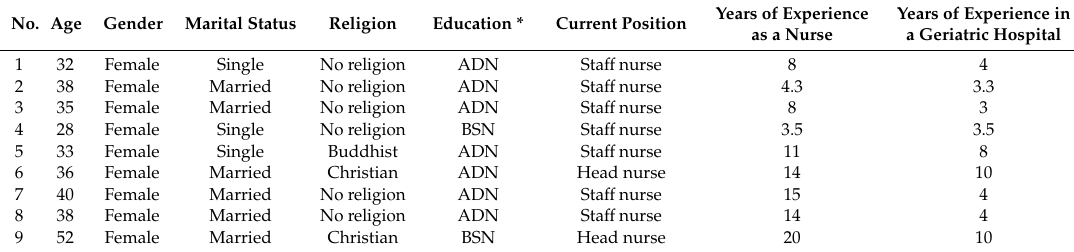
Table 1. Characteristics of the